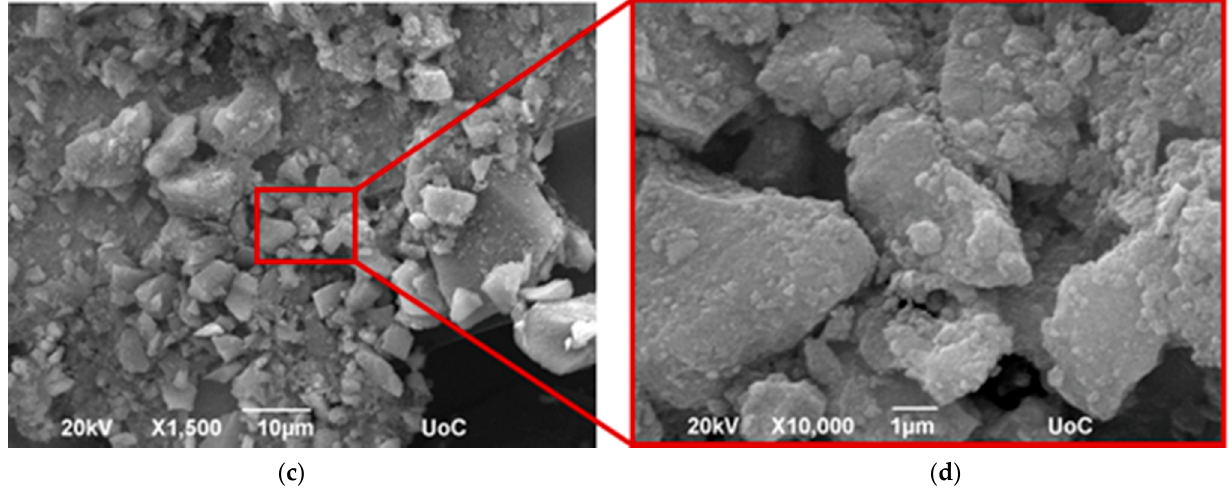
Figure 5. SEM images of ( a , b ) TC25 and ( c , d ) TC62.5 nanocomposites.